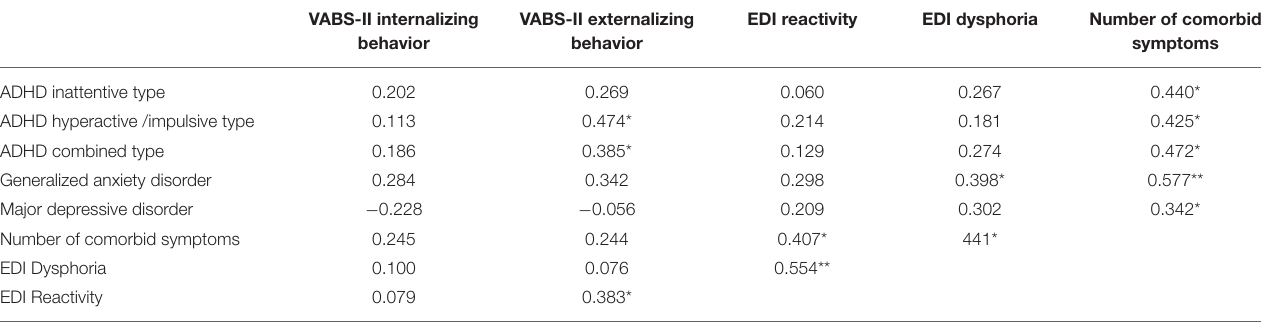
TABLE 6 | Partial correlations between severity scores for selected psychiatric symptom classifications (CASI-5), emotion dysregulation (EDI) factors, and maladaptive behavior (VABS-II), controlling for cognitive ability